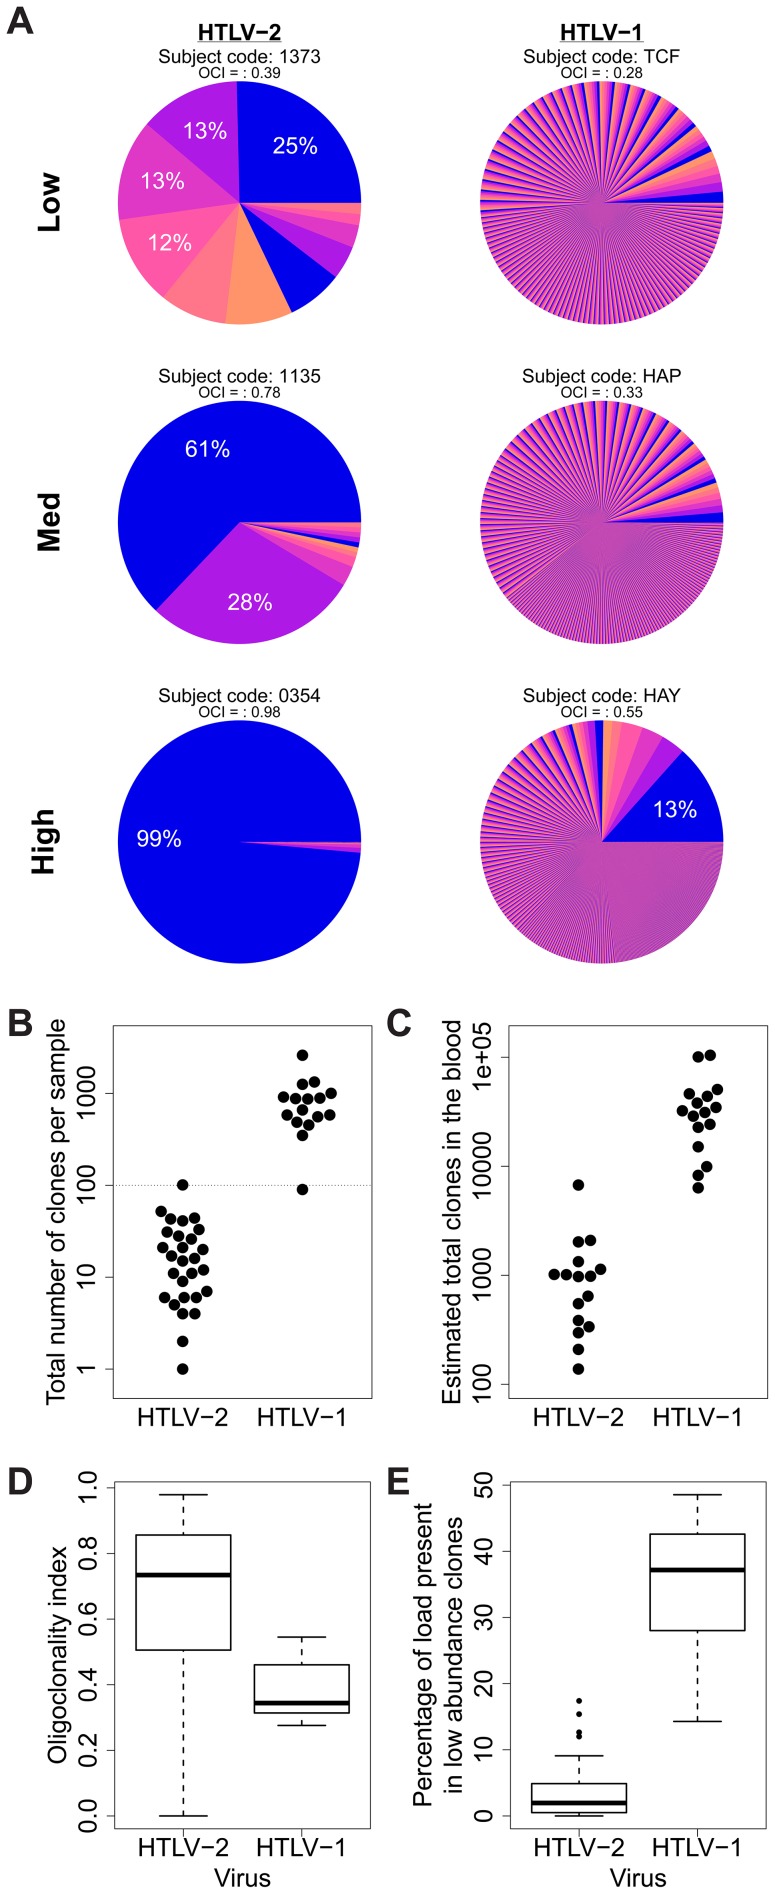
HTLV-2 integration is highly oligoclonal, characterized by small numbers of expanded clones.(A) Clonal distribution in representative subjects with HTLV-1 or HTLV-2 infection. The lowest observed, median and highest observed oligoclonality index values are shown. Each pie slice represents a single clone, proportional to relative abundance. Subjects with >100 proviruses identified are shown. OCI = oligoclonality index. (B) The observed number of clones in each subject with HTLV-1 or HTLV-2 infection (p<0.001, Mann-Whitney test). (C) The total number of clones in the blood was estimated using the DivE estimator (Laydon et al., manuscript submitted). Only samples containing sufficient information are shown. For each subject, the population size of infected cells in the blood was estimated based on the proviral load and average PBMC count. The estimated total number of clones in the blood was between 1 and 2 orders of magnitude lower in HTLV-2-infected subjects than in HTLV-1-infected subjects (p<0.001, Mann-Whitney test). (D) The oligoclonality index across all HTLV-1 -infected subjects compared to HTLV-2-infected subjects (p<0.001, Mann-Whitney test). (E) The percentage of the load maintained by clones observed only once compared between HTLV-1 and HTLV-2 (p<0.001, Mann-Whitney test).